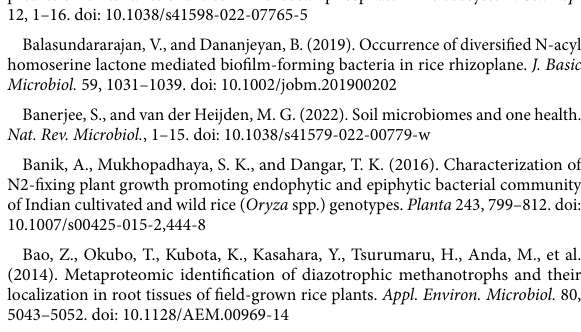
SUPPLEMENTARY FIGURE 1 Random forest machine learning coupled rhizo-microbiome co- occurrence network analysis of ten rice varieties, the size of the nodes is arranged based on their betweenness centrality values, nodes having the highest radius are depicted as keystone taxa; HUR 917 (A) , MTU1001 (B) , BPT5204 (C) , Warangal 3207 (D) , TKM13 (E) , HUR 105 (F) , CO52 (G) , Rajender Sweta (H) , MTU 7029 (I) and SHIATS 1 (H) . SUPPLEMENTARY FIGURE 2 Correlogram depicting significant microbiome associations (p < 0.05) of bacterial taxa representing rhizo-microbiome of rice variety HUR 917, p <0.05. SUPPLEMENTARY FIGURE 3 Correlogram depicting significant microbiome associations of bacterial taxa representing rhizo-microbiome of rice variety MTU1001. SUPPLEMENTARY FIGURE 4 Correlogram depicting significant microbiome associations of bacterial taxa representing rhizo-microbiome of rice variety BPT5204. SUPPLEMENTARY FIGURE 5 Correlogram depicting significant microbiome associations of bacterial taxa representing rhizo-microbiome of rice variety Warangal 3207. SUPPLEMENTARY FIGURE 6 Correlogram depicting significant microbiome associations of bacterial taxa representing rhizo-microbiome of rice variety TKM13. SUPPLEMENTARY FIGURE 7 Correlogram depicting significant microbiome associations of bacterial taxa representing rhizo-microbiome of rice variety HUR105. SUPPLEMENTARY FIGURE 8 Correlogram depicting significant microbiome associations of bacterial taxa representing rhizo-microbiome of rice variety CO52. SUPPLEMENTARY FIGURE 9 Correlogram depicting significant microbiome associations of bacterial taxa representing rhizo-microbiome of rice variety Rajender Sweta. SUPPLEMENTARY FIGURE 10 Correlogram depicting significant microbiome associations of bacterial taxa representing rhizo-microbiome of rice variety MTU 7029. SUPPLEMENTARY FIGURE 11 Correlogram depicting significant microbiome associations of bacterial taxa representing rhizo-microbiome of rice variety SHIATS 1. SUPPLEMENTARY FIGURE 12 Differential abundance of top fifty gene families associated with rhizo- microbiome of rice variety. As revealed by Lefse analysis (A) and Heatmap showing the distribution of the top fifty gene families associated with the rhizo-microbiome of rice, the color gradient towards orange and green represents high and low abundance as indicated in the scale bar. SUPPLEMENTARY DATA FILE 1 XLSX table containing a tab with the full list of the taxa with taxonomy, prevalence, and relative abundance. SUPPLEMENTARY DATA FILE 2 XLSX table containing a tab with the full list of the genus and mean relative